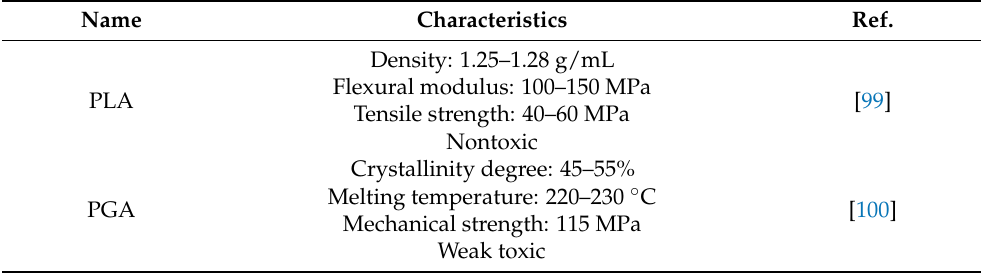
Table 3. Main characteristics of the synthetic polymer